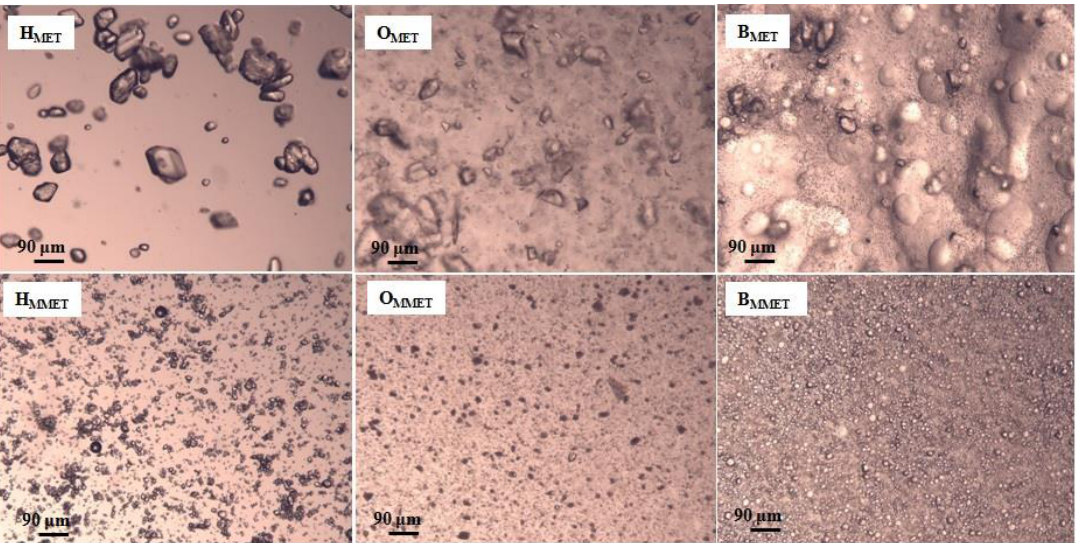
Figure 2. Microscopic images of prepared hydrogels, oleogels and bigels containing MET (HMET, OMET, BMET) or MMET (HMMET, OMMET, BMMET) under magnification 100×.